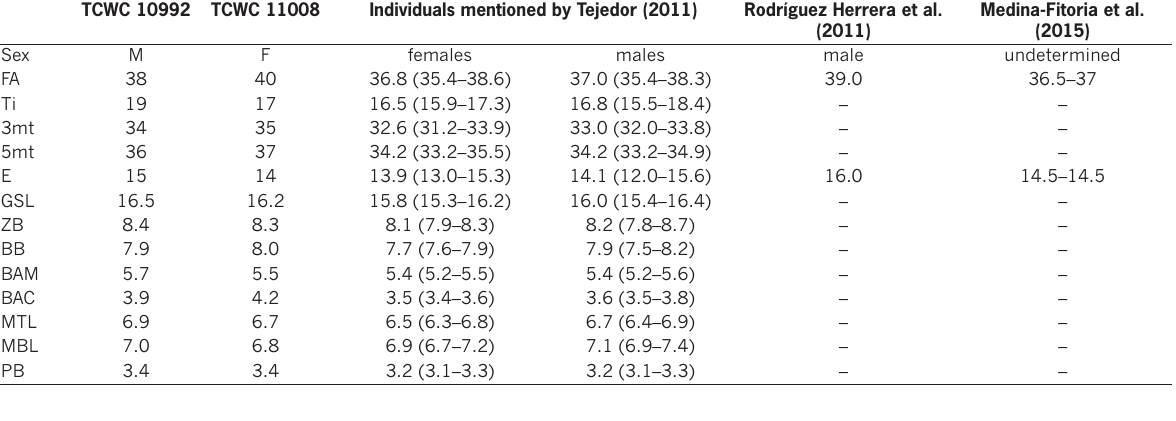
Table 3. Comparison of N. lanatus specimens that comprise new records for Honduras with individuals captured by Tejedor (2011) in Mexico, Nicaragua (Medina-Fitoria et al. 2015), and Costa Rica (Rodríguez Herrera et al. 2011). Means (ranges in parentheses); all the measurements are in mm.